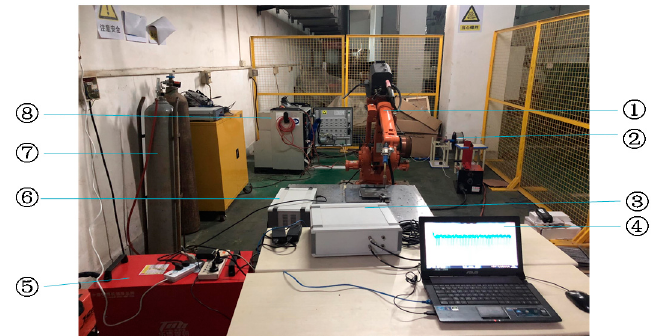
Figure 10. Experiment and testing platform for the double pulse MIG welding, ① Welding robot; ② Welding wire feeding mechanism; ③ the are signal acquisition box; ④ Computer; ⑤ Welding machine; ⑥ the arc sensor box; ⑦ The argon gas storage tank; ⑧ The power supply. Table 1. Welding process parameters.